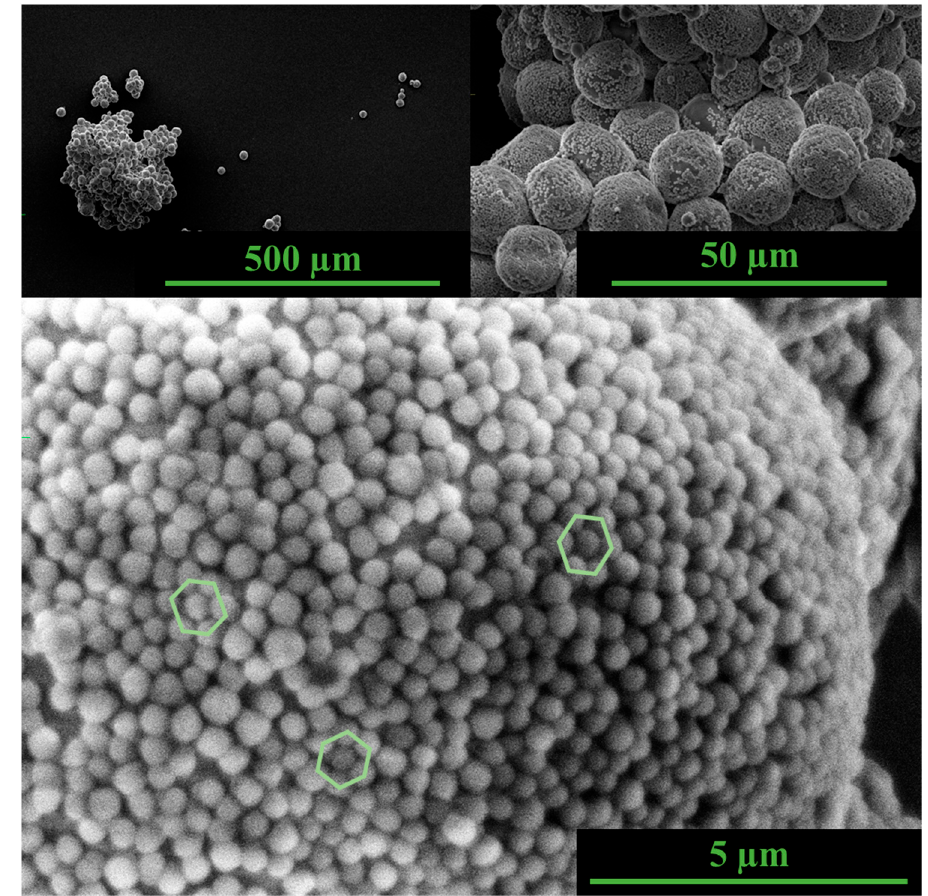
Figure 2. Wax colloidosomes obtained with JNP-bPEI 4 mL.